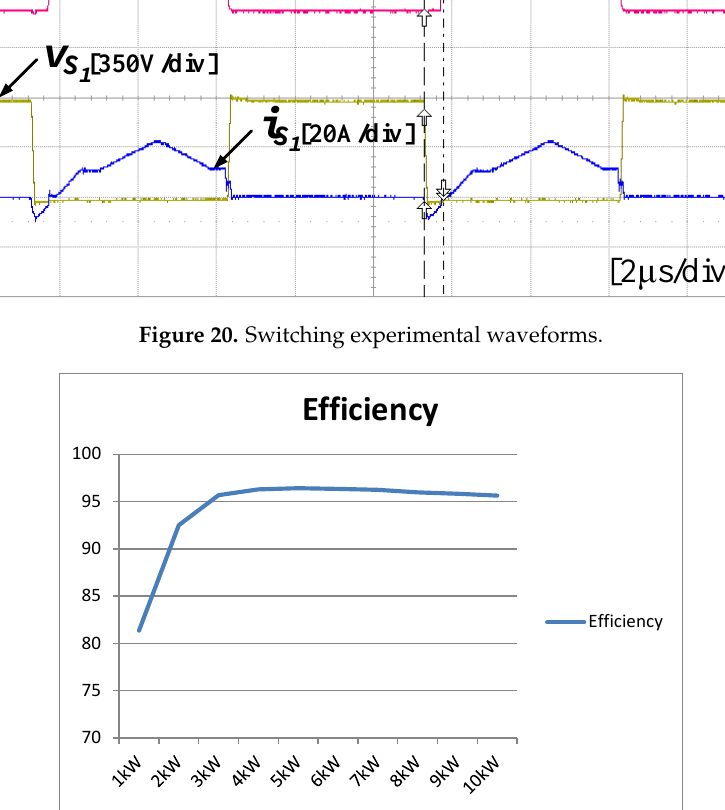
Figure 20. Switching experimental waveforms.